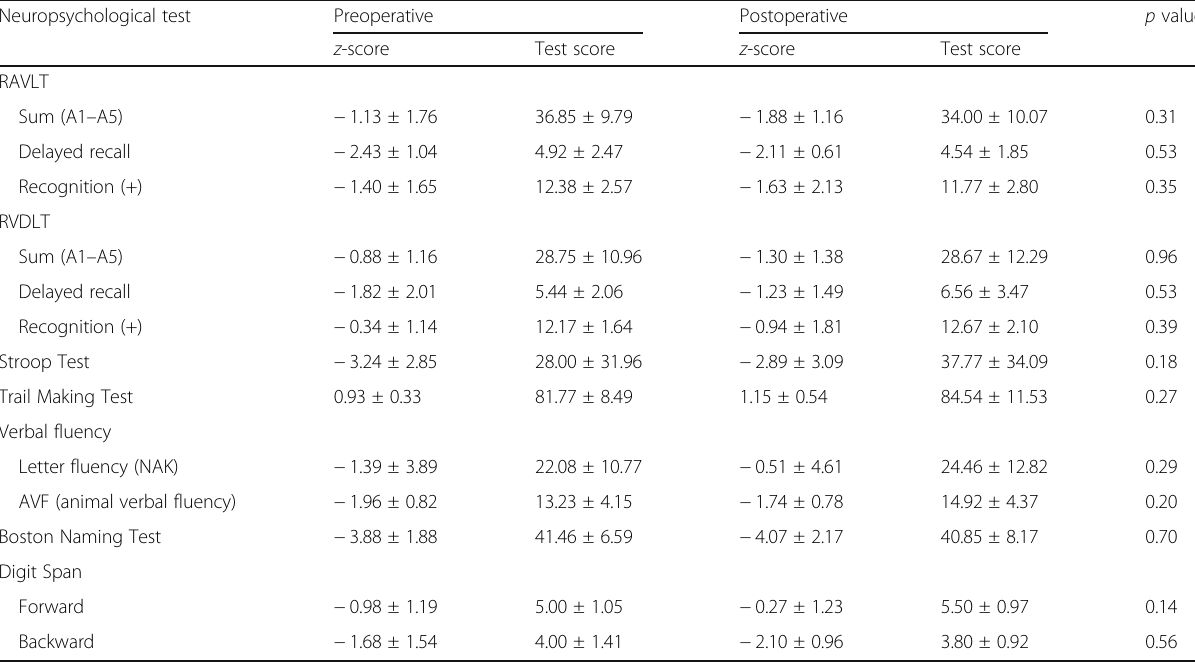
Table 2 Changes in neuropsychological measures after epilepsy surgery Neuropsychological test